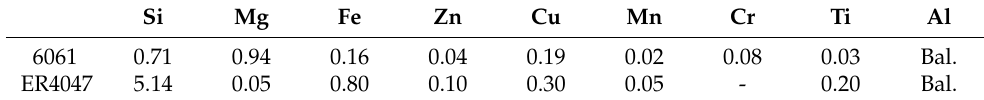
Table 1. Chemical compositions of the 6061 Aluminum Alloy and the filler wire (mass fraction, wt.%).